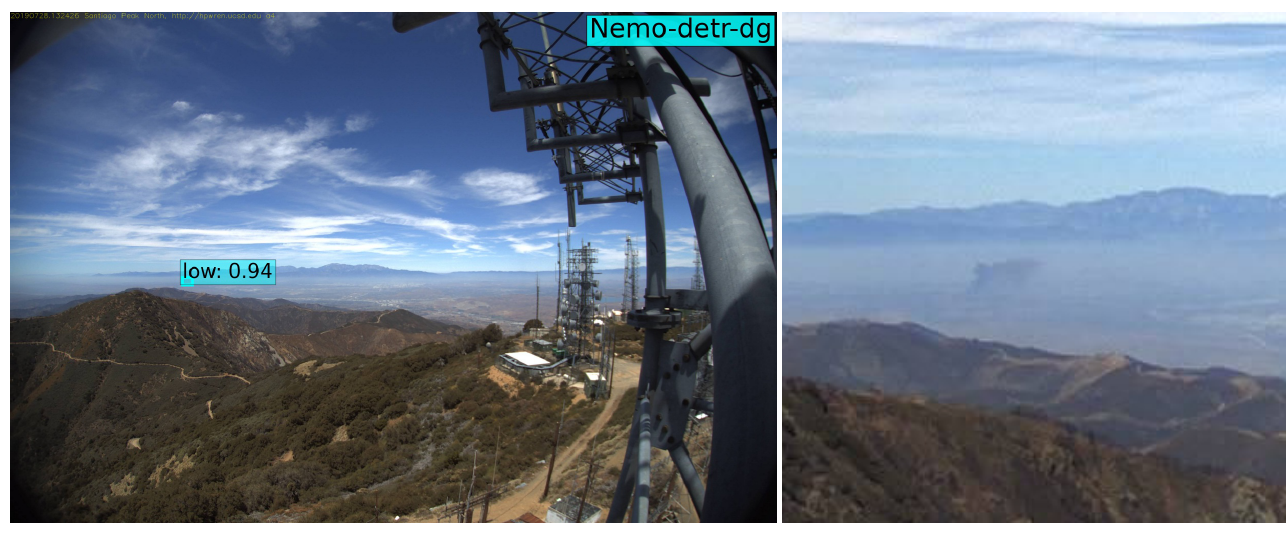
( e ) Correct detection—13:24 (smoke/image size = 0.00016) ( f ) The zoomed cutout of the smoke region in (e) Figure 16. The video sequence shown is from sp-n-mobo-c__2019-07-28 (Row 72). The images are 6 MP in size (i.e., 3072 × 2048) and were captured from a north-facing wide camera on top of Santiago Peak in Southern California. ( a ) shows the ignition at 13:17 marked with a red arrow due to the small size; ( b ) a 300 × 300 cutout of the ignition. We can notice that the smoke is not visible due to the small size, distance, and a background that is already smoggy. ( c ) A missed detection is shown 4 min after ignition at 13:21. The size of the smoke is 19 × 16 pixels, which is 0.0048% of the image (i.e., 3072 × 2048). ( d ) Note that the smoke is barely visible even in the 300 × 300 cutout. ( e ) The first correct detection is shown 7 min after ignition. The smoke is now 43 × 23 pixels, which is much larger than Minute 4, but still very small relative to the image dimension (0.01% of the image). ( f ) shows the cutout for the correctly detected